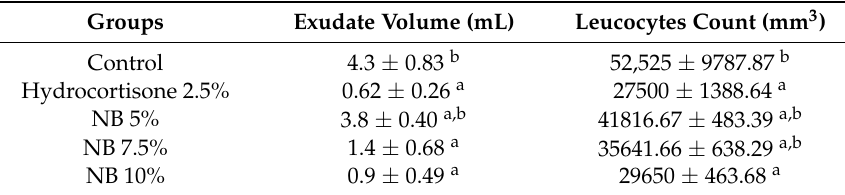
Table 3. Granuloma pouch exudate examination.